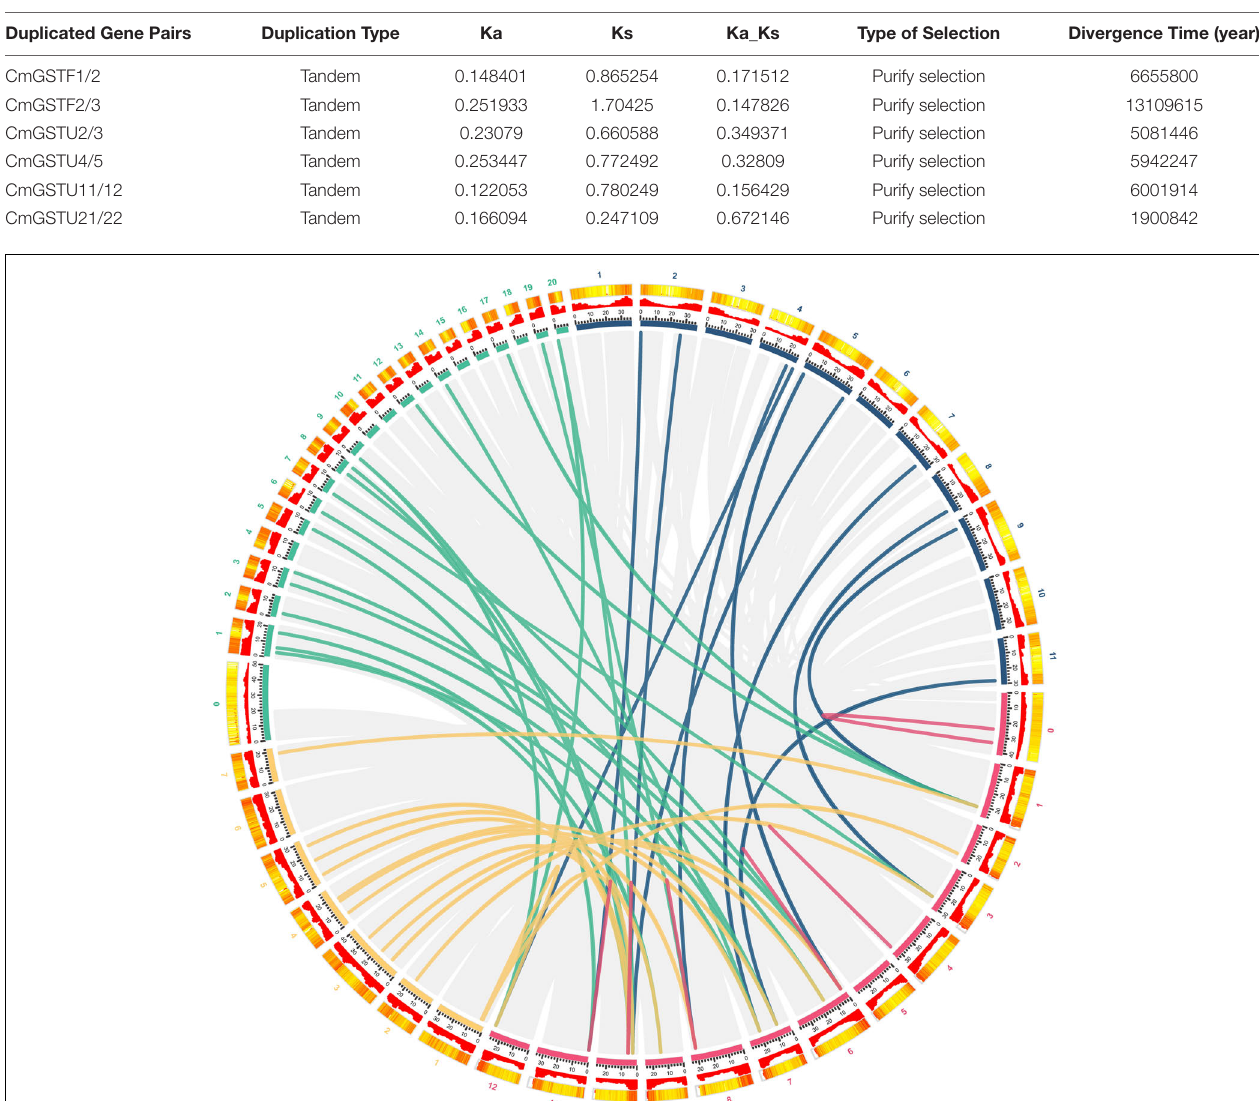
TABLE 1 | Ka/Ks values and divergence time of six CmGST duplication gene pairs.